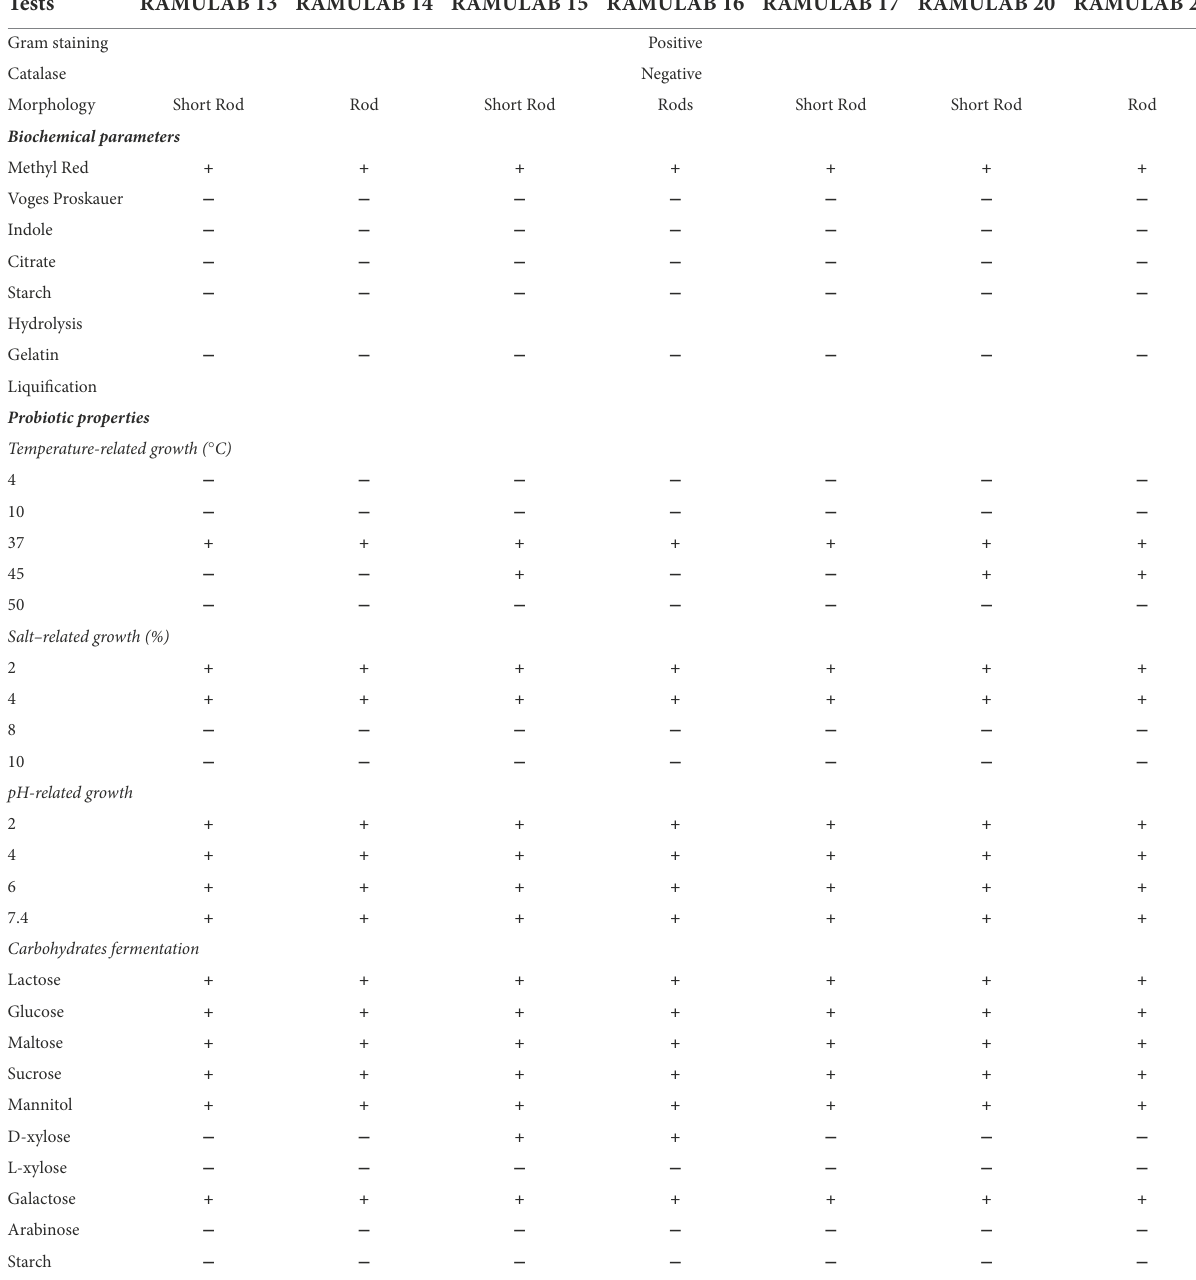
“+” indicates presence and “ − ” indicates